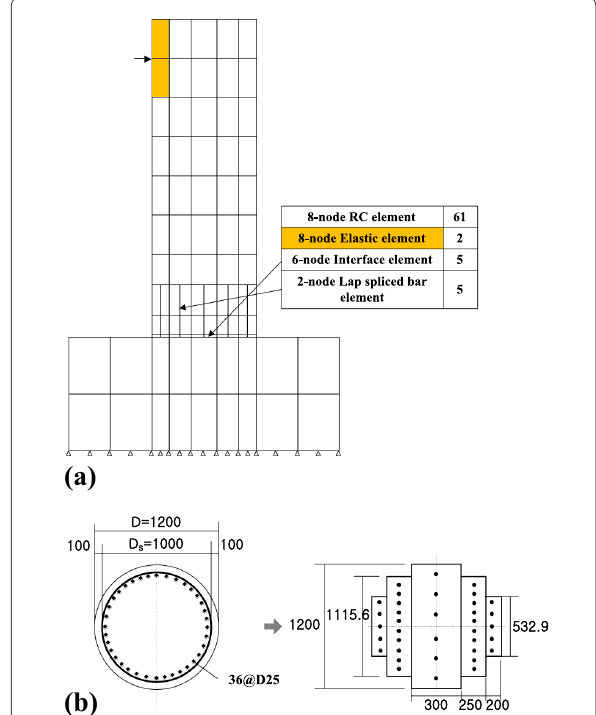
Fig. 9 Finite element model for FS series: a finite element mesh and b transformation of a circular column to an idealized equivalent rectangular column (Unit: mm).